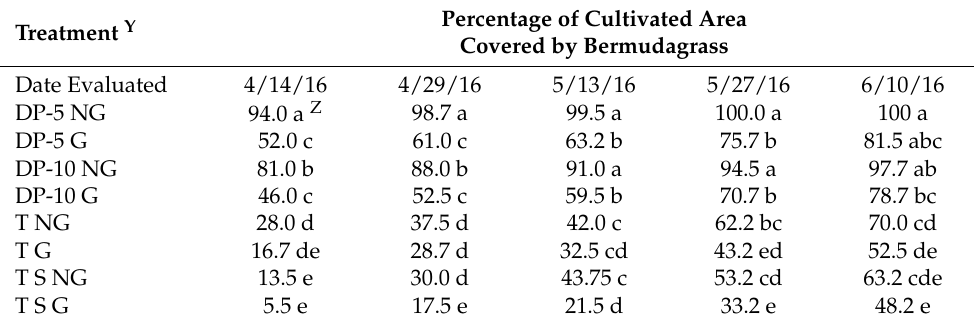
Percentage of Cultivated Area Covered by Bermudagrass